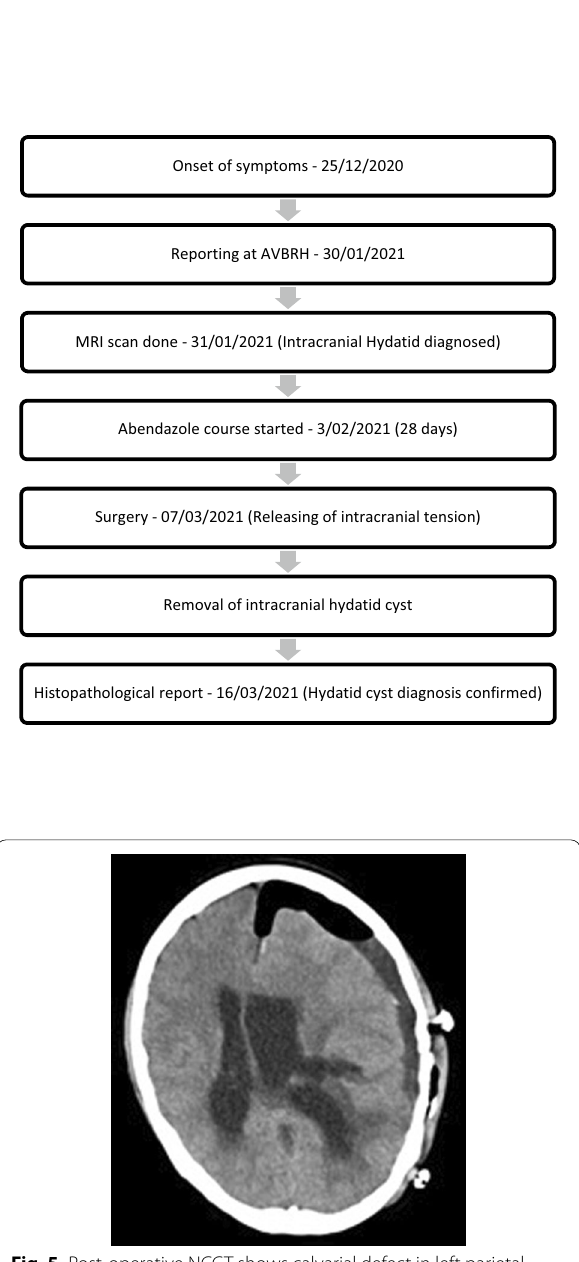
Fig. 5 Post-operative NCCT shows calvarial defect in left parietal bone with postoperative changes. No residual hydatid